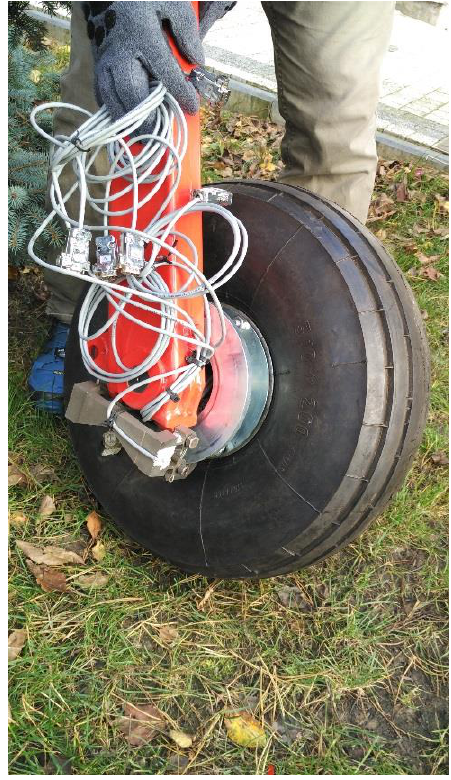
Figure 2. The complete wheel force sensor.